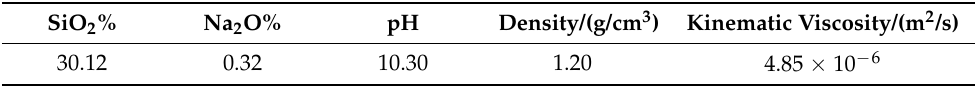
Table 4. Physical and chemical properties of colloidal silica.